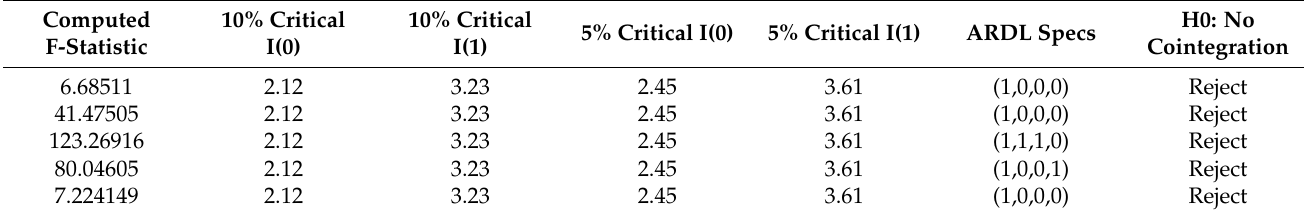
Table A3. The results of the bounds test for cointegration for RMW.